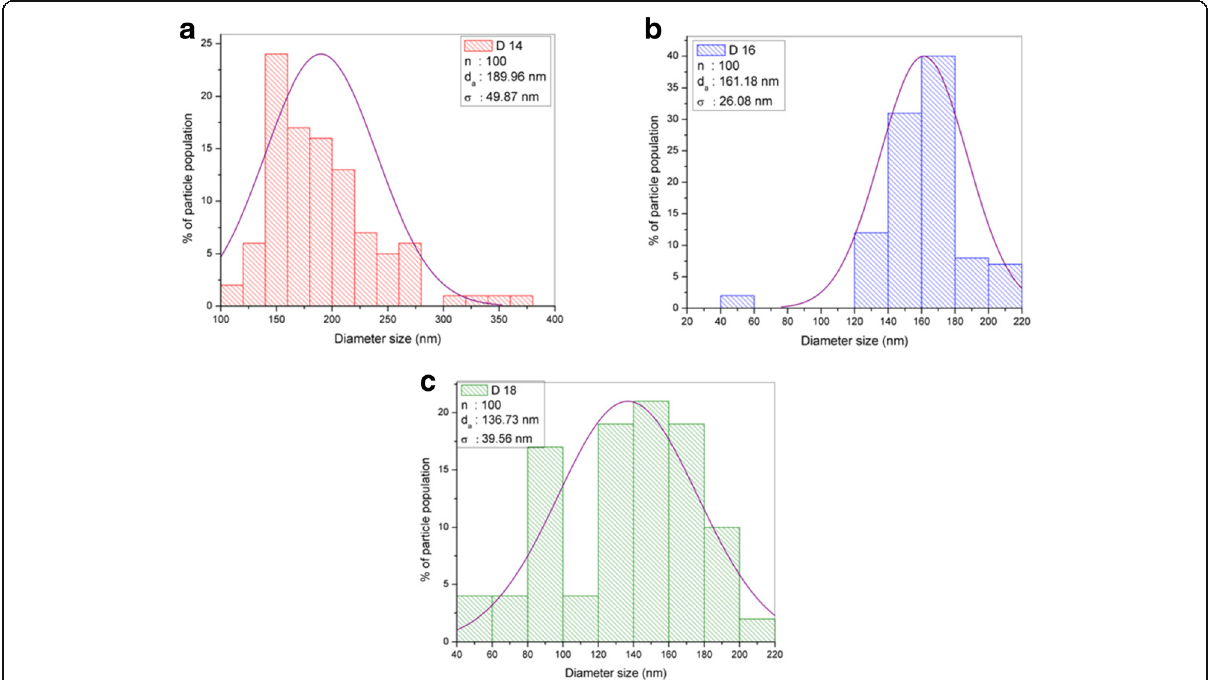
Fig. 9 Histogram data of diameter size distribution with the parameter of n, d a , and σ . a TiO 2 -CNF (D14). b TiO 2 -CNF (D16). c TiO 2 -CNF (D18)